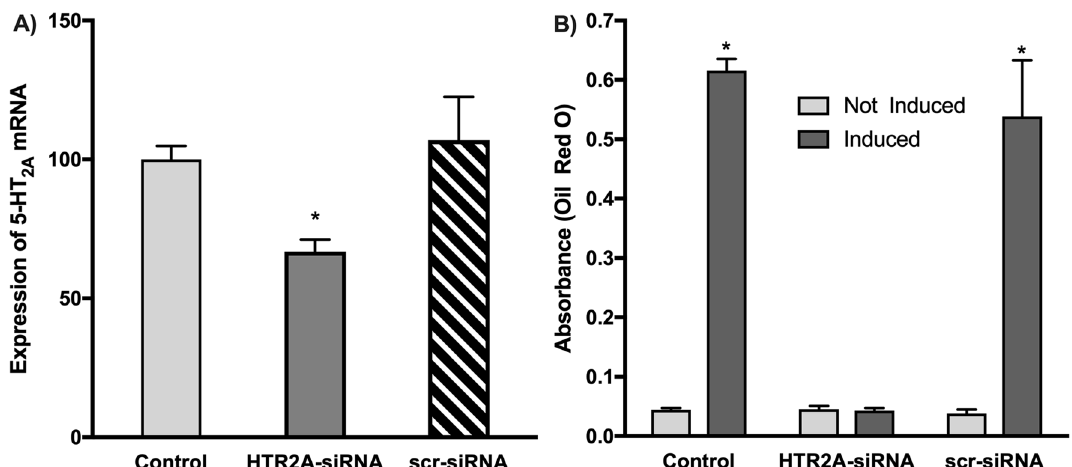
Figure 4. Knockdown of 5-HT 2A receptor mRNA blocks differentiation. ( A ) QPCR was performed on transfected cells at day 2 to determine that knockdown with the 5-HT 2A receptor siRNA (HTR2A-siRNA) was 30% below normal expression levels, and below levels after transfection with the scrambled siRNA (scr-siRNA). (* p > 0.05; ANOVA with Tukey post hoc test; n = 3 biological replicates per treatment, with 3 technical replicates per biological replicate per gene expression data point; error = ± SEM). ( B ) Cells were mock-transfected (no nucleotide; control), transected with siRNA against 5-HT 2A receptor mRNA (HTR2A-siRNA), or transfected with the same amount of scrambled siRNA (scr-siRNA). Half of the cells were induced, while the remaining half were not induced. At day 14, the extent of differentiation was determined by oil red O staining. Only siRNA directed against 5-HT 2A receptor mRNA was able to block